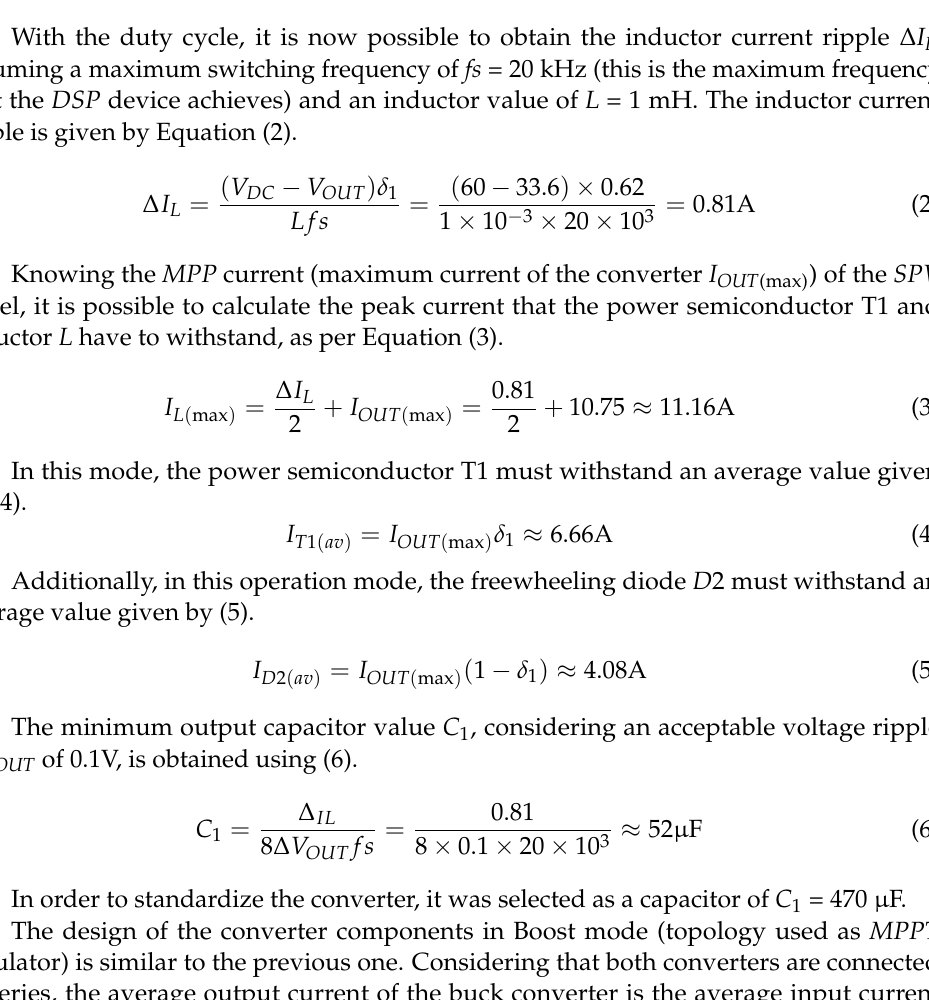
Table 2. Characteristics of an SPV panel with the maximum power of the proposed converter (in STC ) [32]. Parameter Value Voltage at MPP 33.6 V Current at MPP 10.75 A Power at MPP 365 W Open-circuit voltage 41.13 V Short-circuit current 11.3